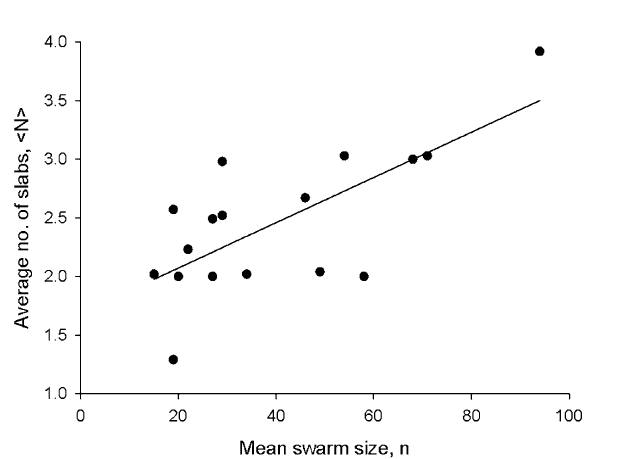
4 w N N tends to increase with increasing average N 1 = = (cid:31)